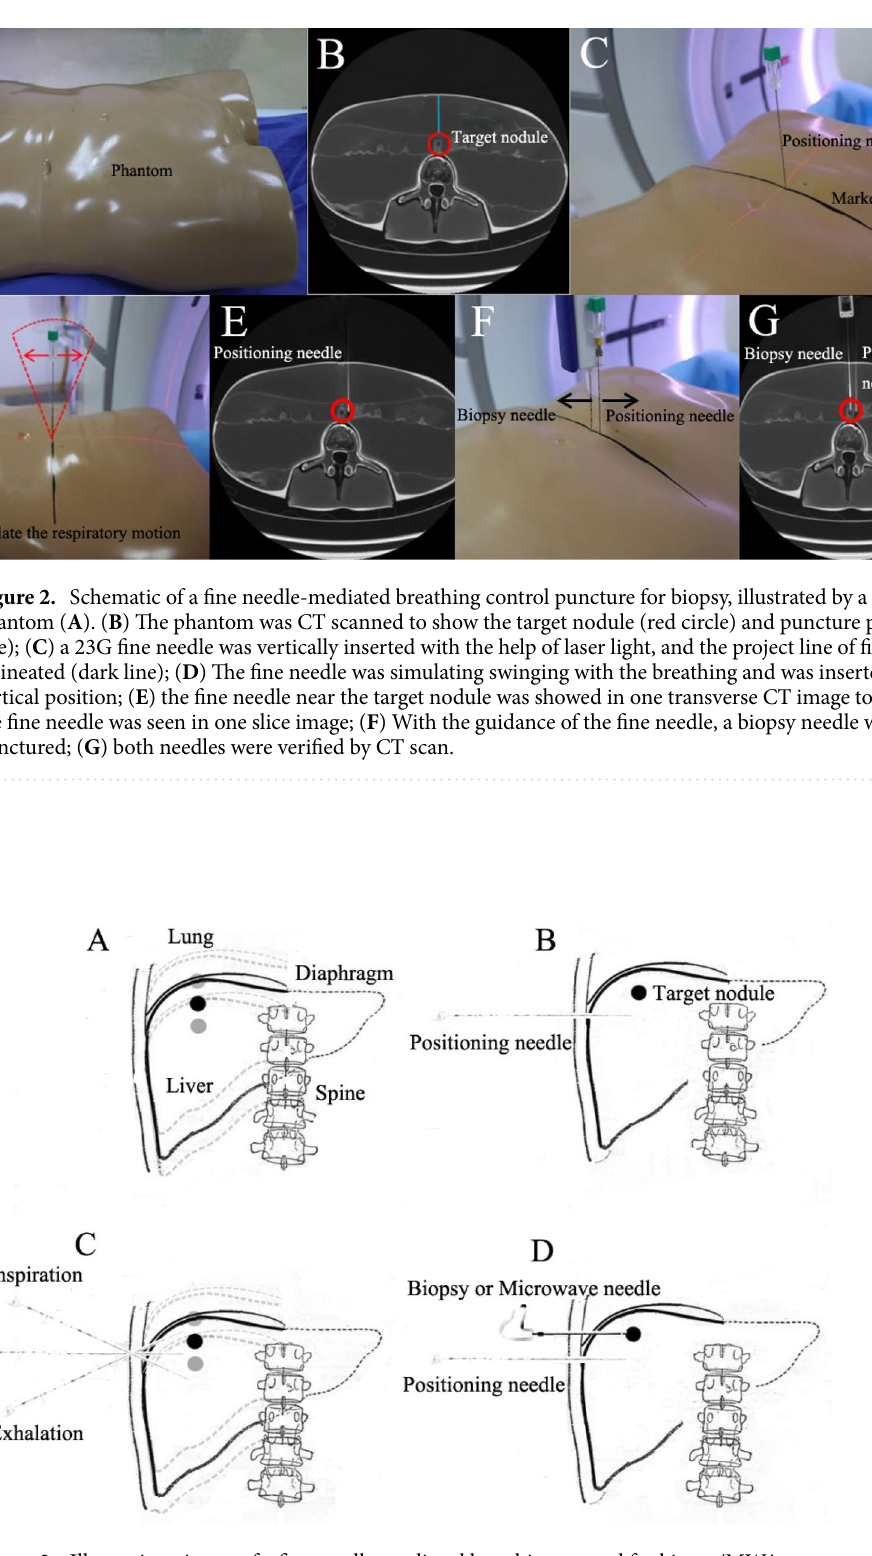
Figure 3. Illustrating picture of a fine needle-mediated breathing control for biopsy/MWA puncture technique for a liver nodule near diaphragm. ( A ) A nodule was showed in liver with 1 cm distance from its up edge to diaphragm swinging up and down with respiratory movement; ( B ) Patient was trained to hold his breath (no matter expire or inspire), a 23G fine needle was inserted near the target nodule (usually 1-5 cm away from the nodule) to serve as a breathing indicator; ( C ) The fine needle acted as a breathing marker. ( D ) While the fine needle was visible on one CT transverse image (right on vertical position to the skin), a biopsy/ablation needle was pierced into the liver nodule as planned and confirmed by CT